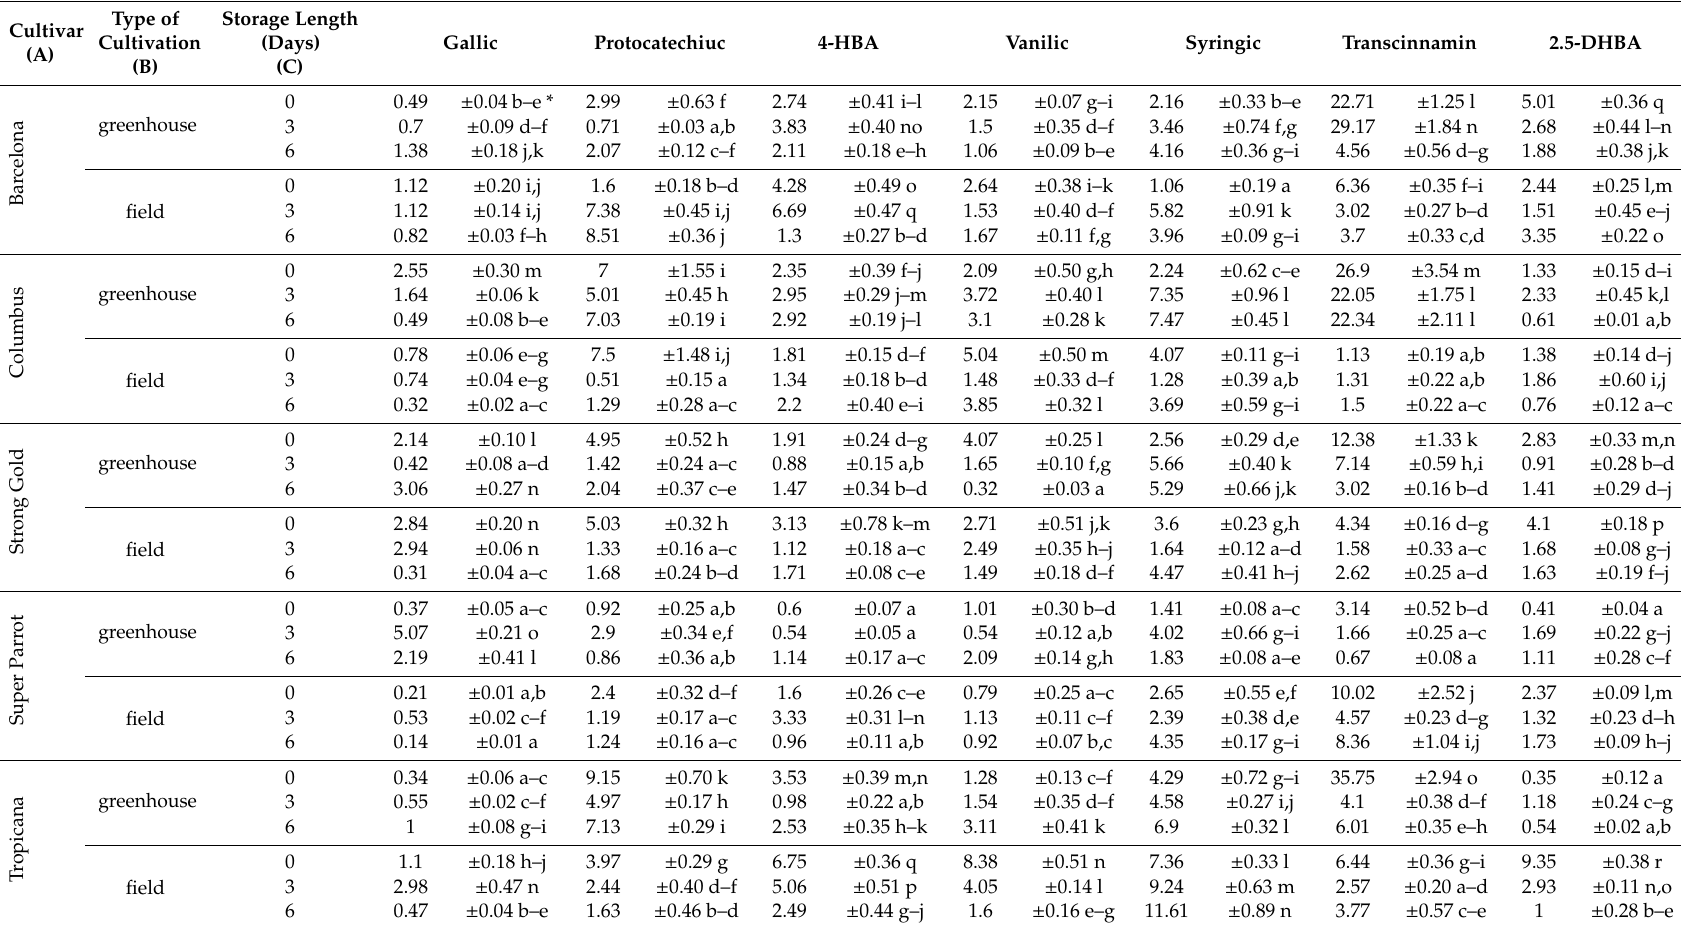
Table 2. Profiling of phenolic acids of tulip flowers [ µ g g − 1